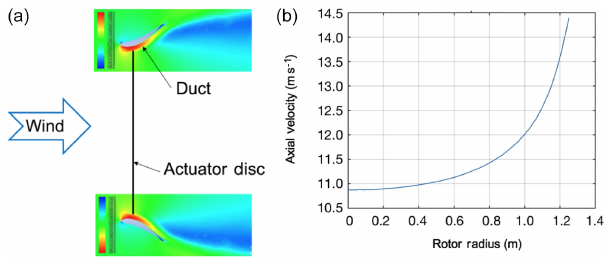
Figure 5. Numerical duct results. (a) Flow field solution. (b) Ex- tracted velocity